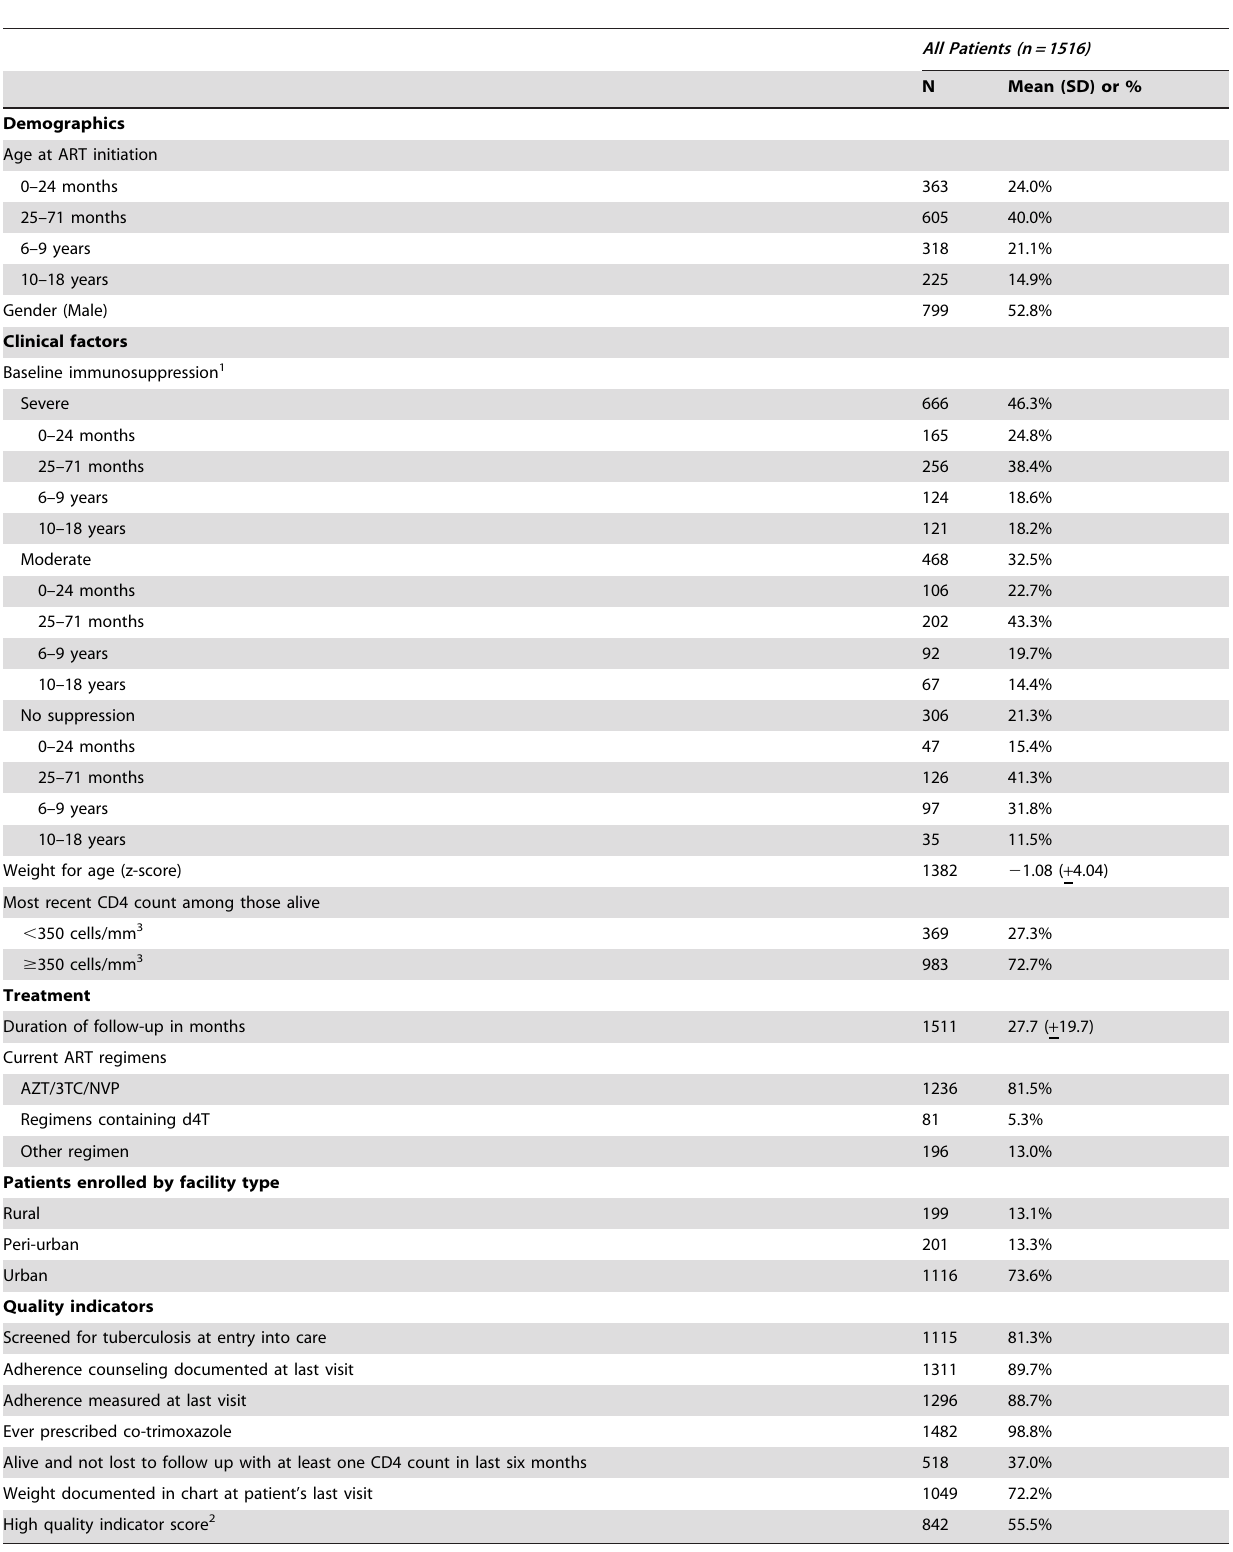
Table 1. Characteristics of sampled pediatric and adolescent patients (age 0 to 18